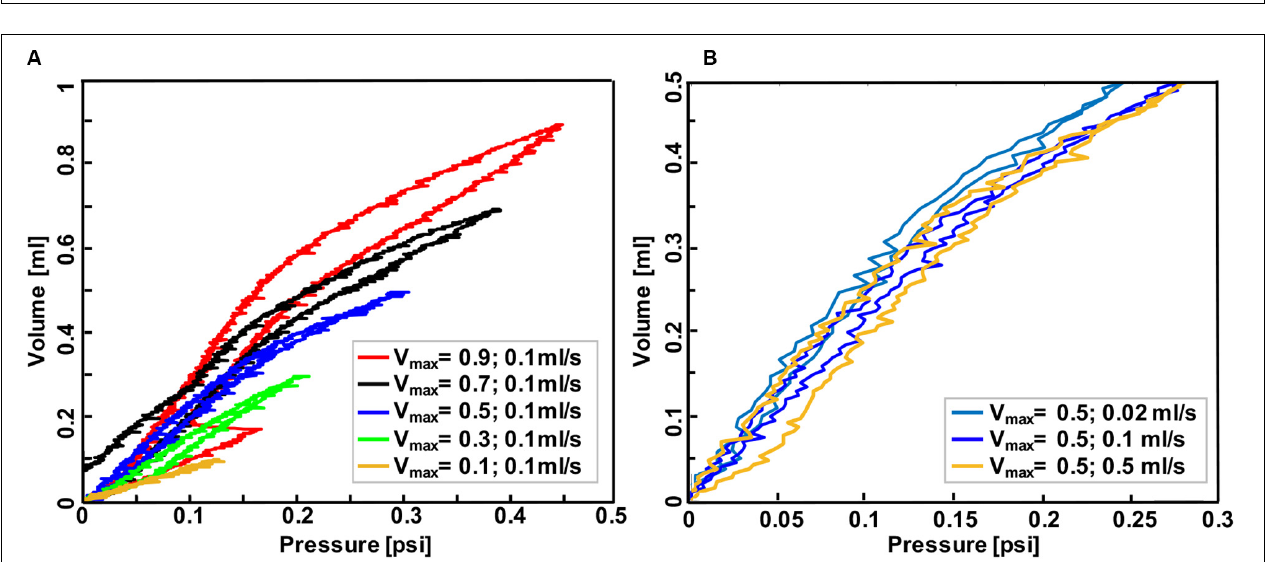
FIGURE 4 | Volume-pressure curve of the third inflation-deflation cycle in mouse #1 (A) and balloon (B) where both maximum inflation-deflation volume and rate was variant: applied volume ranged from 0.1 to 1 ml while the whole inflation-deflation cycles has a duration of 2 s across all experiments. These tests confirmed the system was capable of capturing the expected elastic behavior of the balloon versus inelastic behavior of biological tissues.